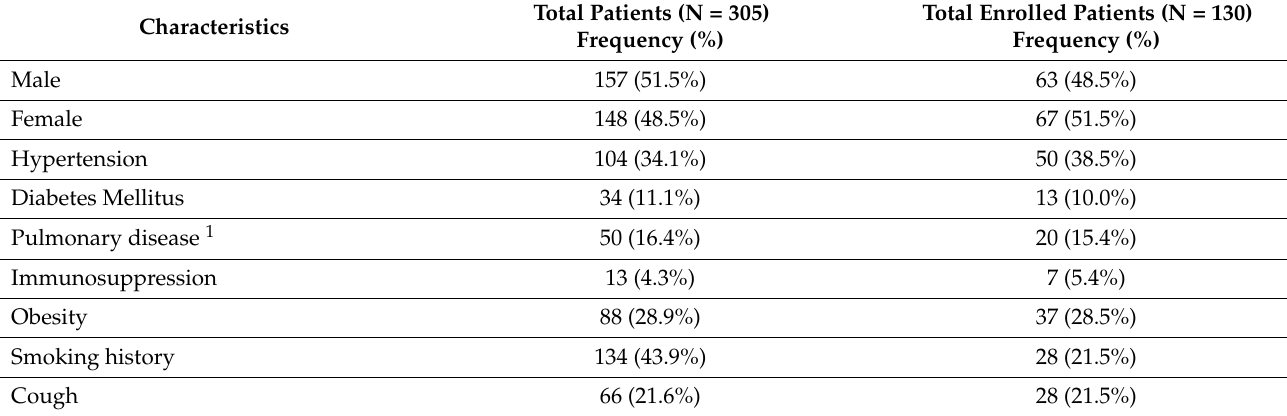
Table 1. Characteristics of enrolled patients. Qualitative